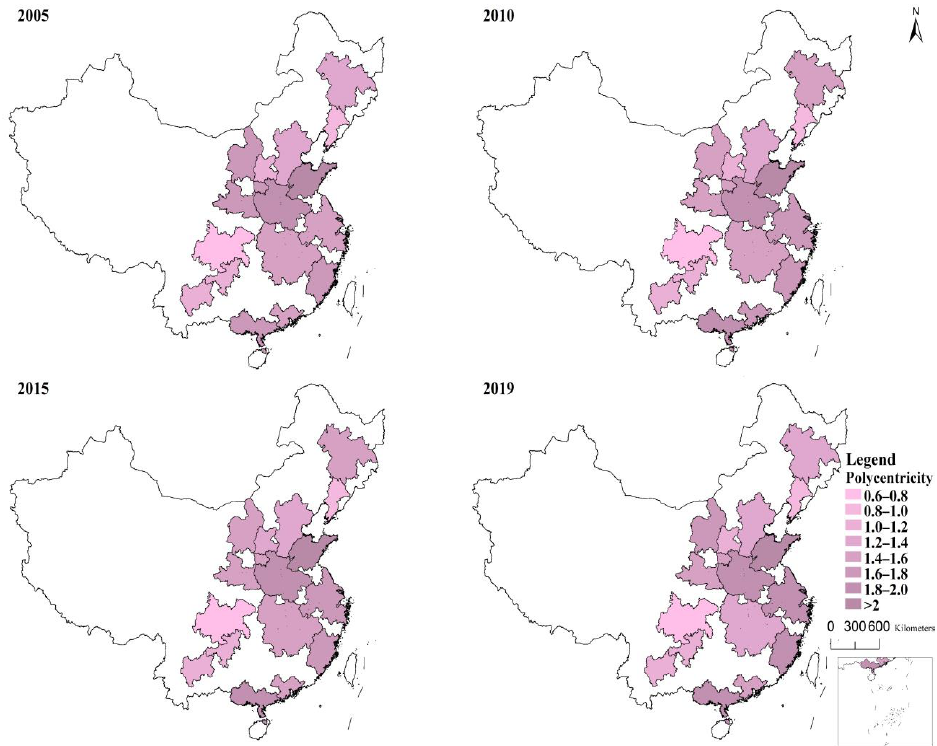
Figure 5. Degree of polycentricity of sample UAs for selected